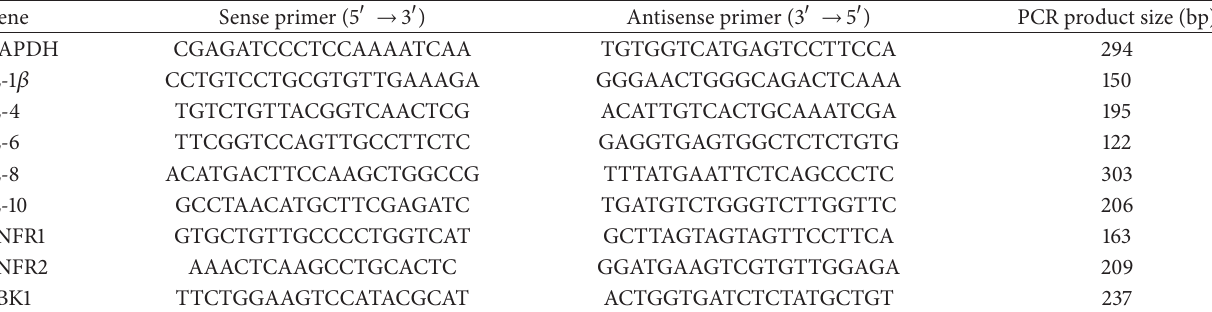
Table 1: PCR primers used in this